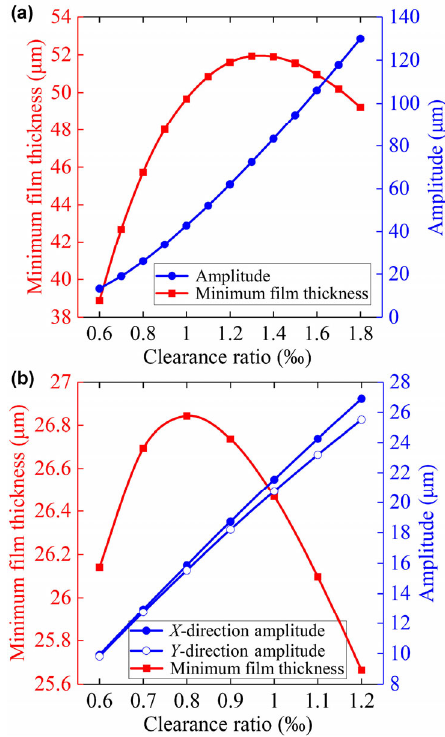
Fig. 13 Minimum film thicknesses and journal amplitudes of a TPJB (a) without and (b) with static loads as a function of clearance ratios.